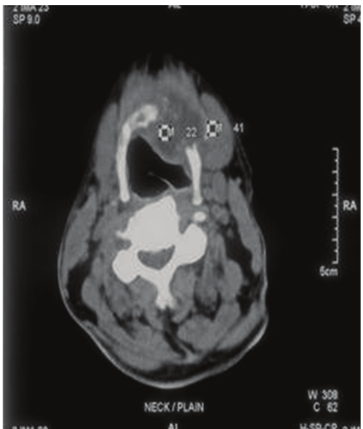
Figure 2: An ill-defined osteolytic lesion of the hyoid with periph- erally enhancing collection.